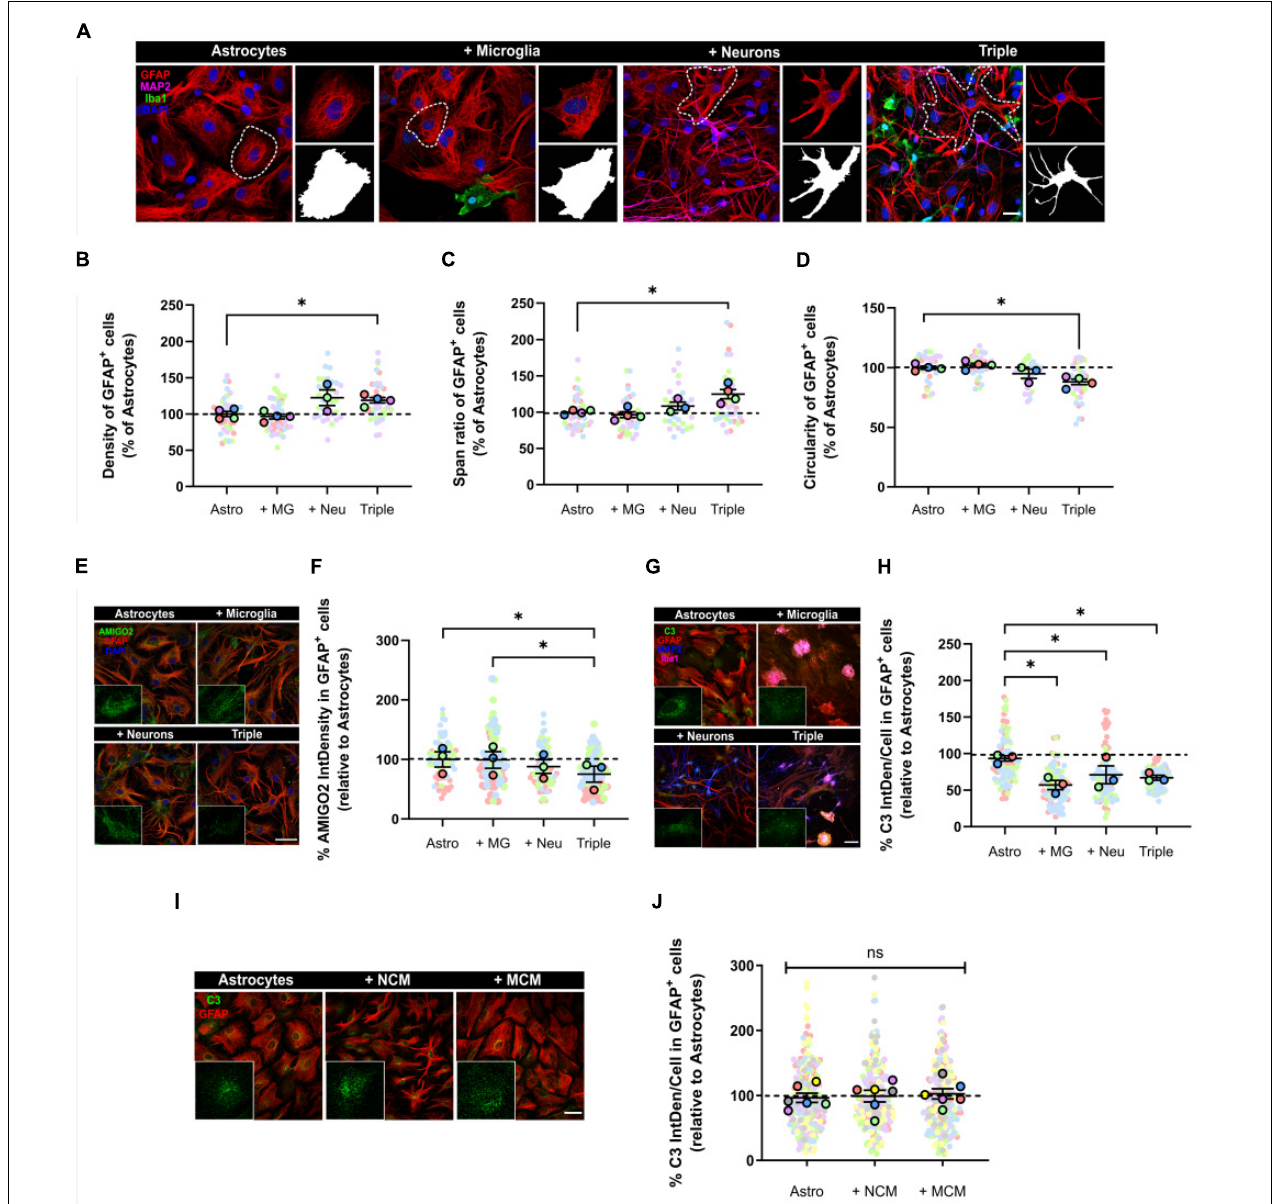
FIGURE 3 | Astrocytes displayed a less reactive morphology and reduced expression of A1 activation markers AMIGO2 and C3. (A) Representative images of the analysis of astrocytic morphology using GFAP and Fractal Analysis in Fiji Software. Black and white images represent the outline of individual cells selected in each condition. Scale bar = 20 µ m. (B) Quantification of the density of GFAP + astrocytes ( n = 4). (C) Quantification of the span ratio of GFAP + astrocytes ( n = 4). (D) Quantification of the circularity of GFAP + astrocytes ( n = 4). (E) Representative image of A1 astrocytic marker AMIGO2. Scale bar = 40 µ m. (F) Quantification of the expression of AMIGO2 inside GFAP + cells ( n = 3). (G) Representative image of A1 astrocytic marker C3. Scale bar = 40 µ m. (H) Quantification of the integrated density of C3 inside GFAP + cells ( n = 3). (I) Representative image of C3 in GFAP + astrocytes after conditioned media treatment. Scale bar = 40 µ m. (J) Quantification of the integrated density of C3 ( n = 6). Each bar represents the mean ± SEM. * p < 0.05; ns, not significant. For quantification, 5–6 random fields per condition were used. Neu, neurons; MG, microglia; Astro, astrocytes; NCM, neuron conditioned media; MCM, microglia conditioned media; IntDen, Integrated